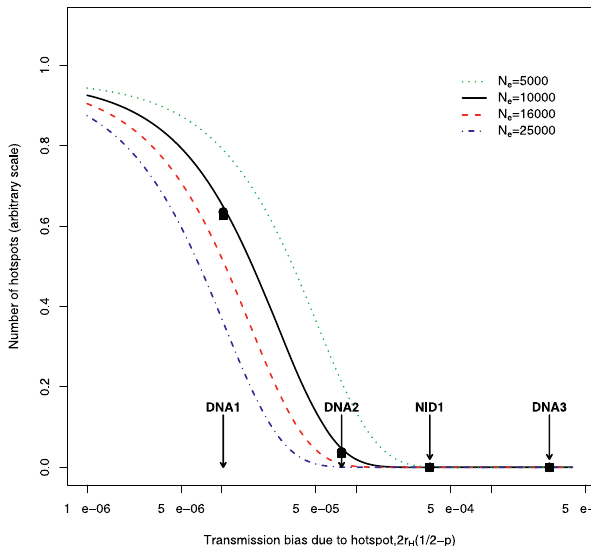
Figure 3. Effects of Demography and Population Size on the Distribution of Hotspot Heats The figure shows the relative expected number of hotspots in the population with frequency above 0.5 for a number of different population sizes and two different demographic models (for low rates of mutation towards [ l H ¼ 10 (cid:2) 8 ] and away [ l D ¼ 2.5 3 10 (cid:2) 7 ] from the hotspot allele). Each line refers to a different effective population size in the range 5,000–25,000. The black squares show results from Wright-Fisher simulations of a European population size model ( N e ¼ 10,659) with a bottleneck beginning 1,600 generations ago and reducing the pop- ulation size 2.5-fold for 1,600 generations, and the black circles show simulation results under a bottleneck model with a 10-fold reduction for 400 generations (for more details of these simulations, see Text S1 section 5). The arrows mark our estimated values for the unscaled drive coefficients at hotspots of the intensity of DNA1–3 and NID1.